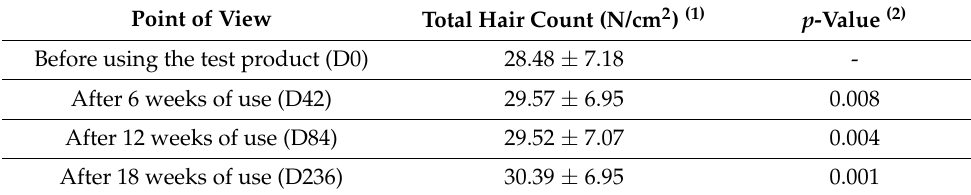
Table 3. Evaluation of the total number of hairs using a phototricogram.